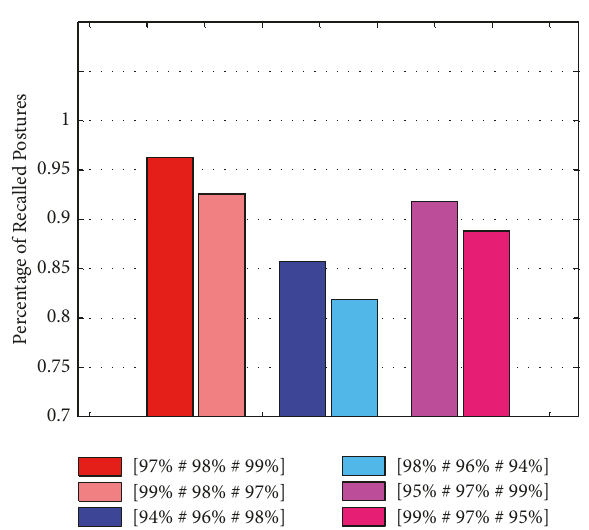
Figure 8: The percentage of detected posture